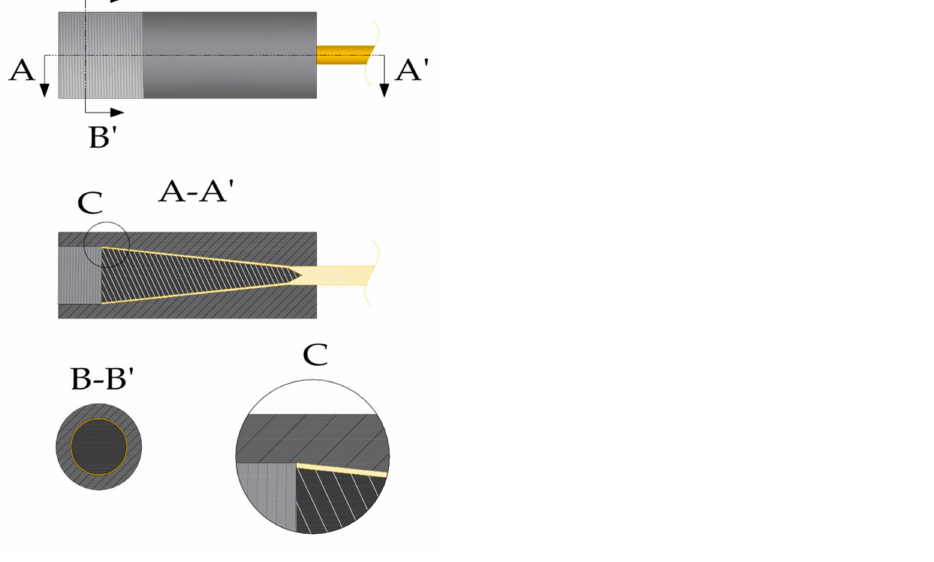
Figure 3. Example of a spike-type anchorage. Detail C magnifies fibers gripped between the conical spike and barrel.